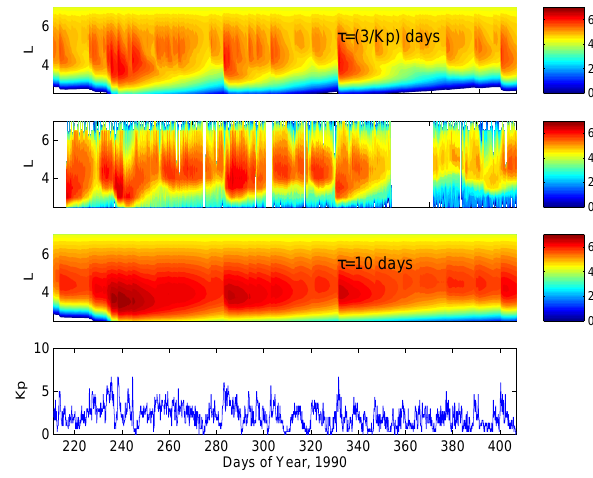
Fig. 1. Comparison between 0.95MeV electron fluxes in log 10 (cm 2 srsMeV) computed by our radial diffusion model with empirical lifetimes (first panel), electron flux measurements on CRESS satellite (second panel). Model simulations with constant lifetimes of 10 days are shown (third panel). The fourth panel shows the evolution of the K p index used for the calculation of the D LL and τ .